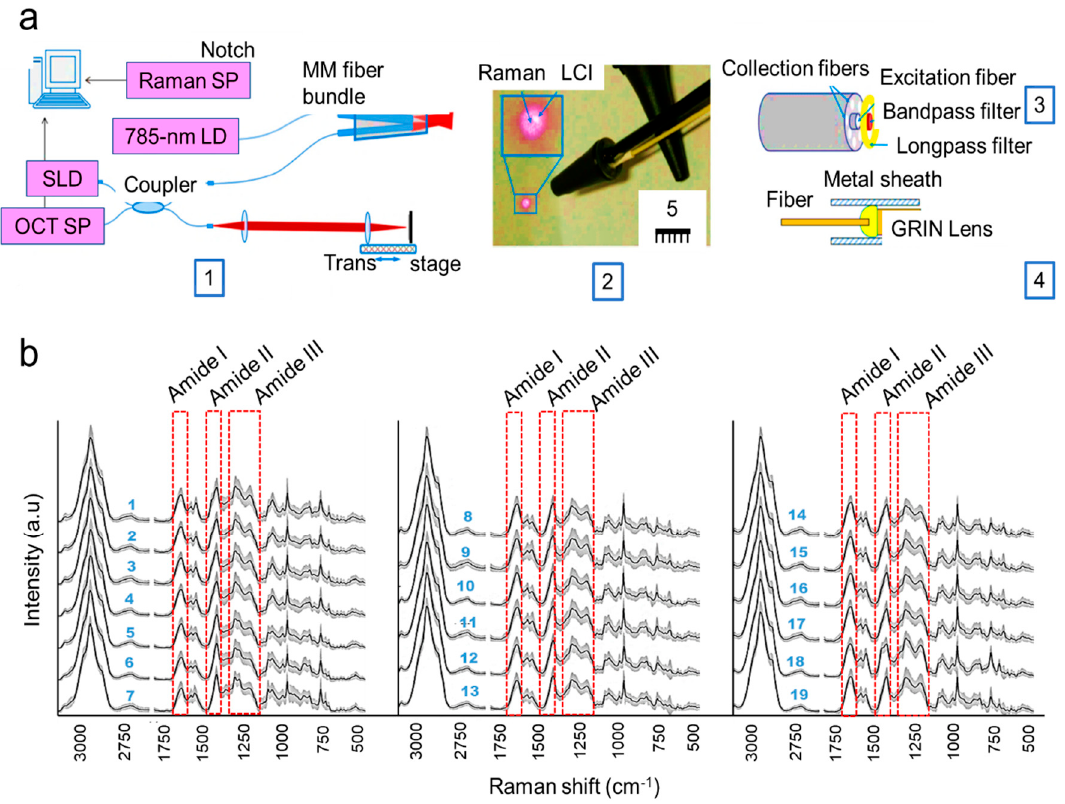
Figure 3. ( a ) Raman and low-coherence interferometry (Raman LCI) ((gradient index (GRIN); spectrometer (SP); laser diode (LD); superluminescence diode (SLD); multimode (MM)). Reproduced with permission from [56]. ( b ) Mean Raman spectra of common bacteria of ear infection. 1: Listeria grayi , 2: Listeria innocua , 3: Listeria monocytogenes , 4: Listeria welshimeri , 5: Staphylococcus aureus , 6: Staphylococcus cohnii , 7: Staphylococcus epidermidis , 8: Escherichia coli , 9: Pseudomonas aeruginosa , 10: Pseudomonas putida , 11: Pseudomonas stutzeri , 12: Salmonella enterica , 13: Salmonella typhimurium , 14: